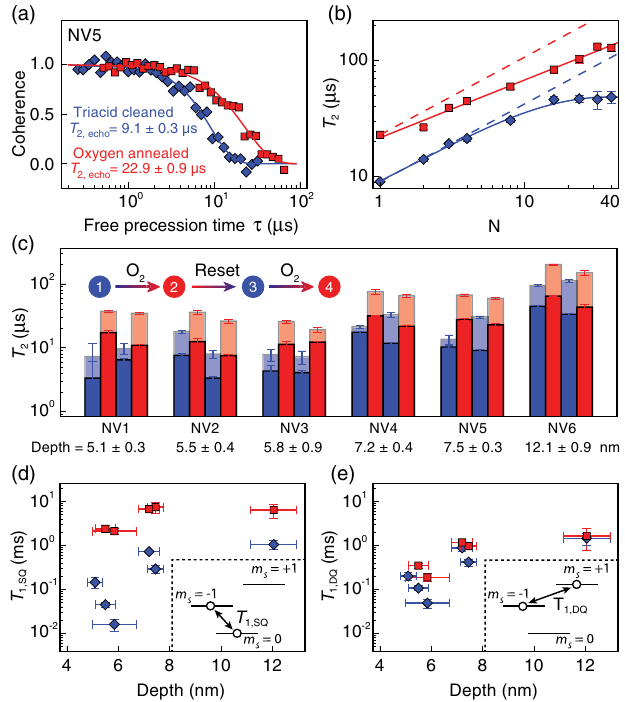
FIG. 2. Comparison of NV centers under the triacid-cleaned (blue diamonds) and oxygen-annealed (red squares) surfaces. (a) Hahn echo decay curves from the same NV center. The Hahn echo coherence time T 2 is improved after oxygen ; echo annealing. (b) Coherence time T 2 as a function of number of the dynamical decoupling pulses N . Dashed lines depict the scaling expected for slowly fluctuating noise, T 2 ∝ N 2 = 3 . (c) Measured T 2 ( N ¼ 1 , opaque) and T 2 , ( N ¼ 8 , transparent) for six ; echo ; XY 8 NV centers through four steps of surface termination and reset (inset), showing that the oxygen annealing is reversible and reproducible. (d),(e) Single- and double-quantum spin relaxation times, T 1 and T 1 , as a function of NV depth (transitions ; SQ ; DQ indicated in insets). T 1 shows a more pronounced improve- ; SQ ment with oxygen annealing compared to T 1 , indicating that ; DQ magnetic noise is more strongly suppressed than electric field